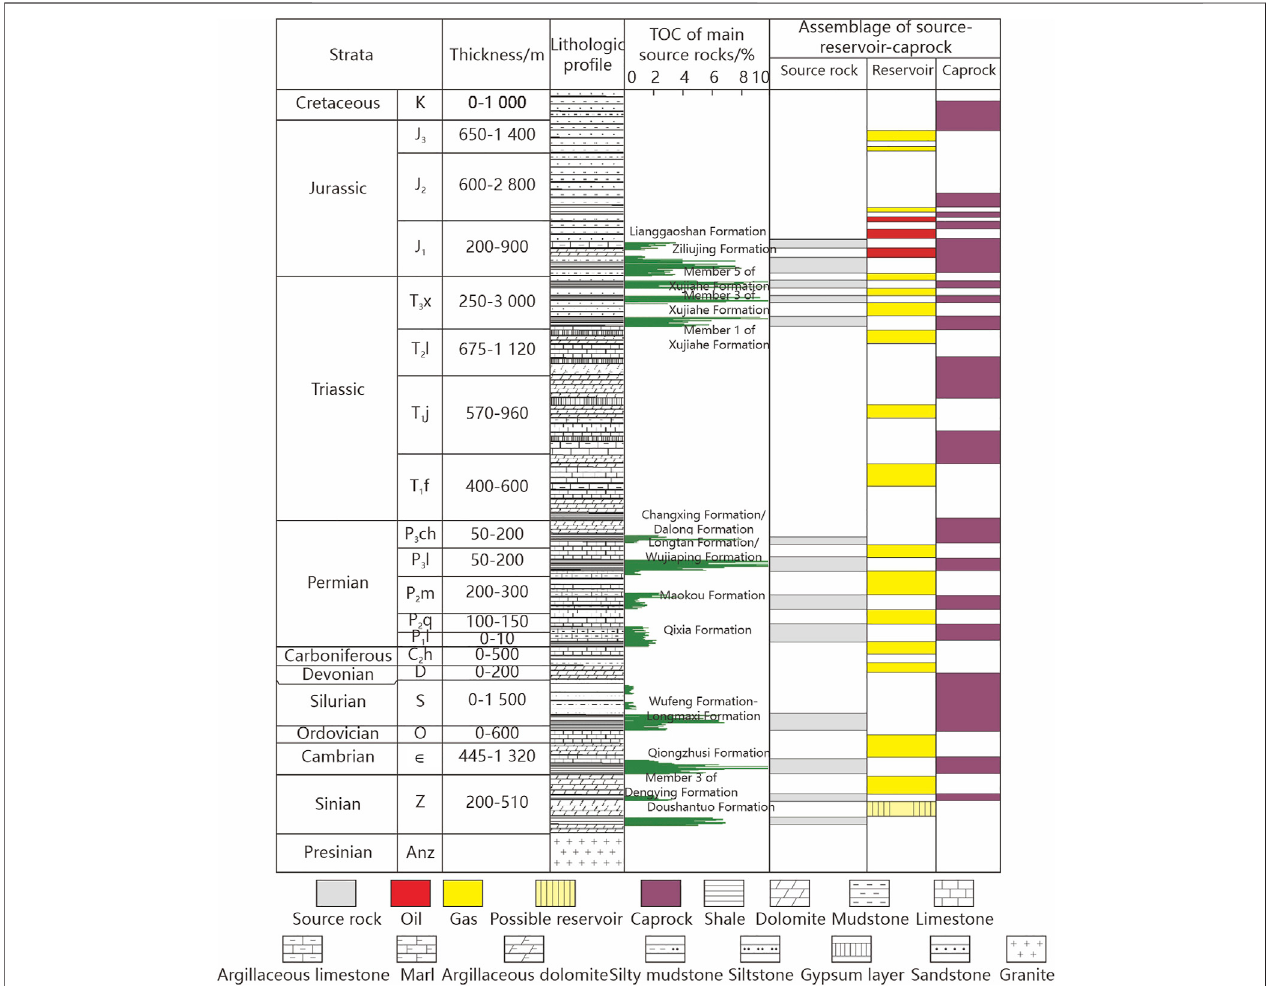
FIGURE 1 | Comprehensive histogram of source-reservoir-caprock in Sichuan Basin. T 3 x-Upper Triassic Xujiahe Formation; T 2 l-Middle Triassic Leikoupo Formation;